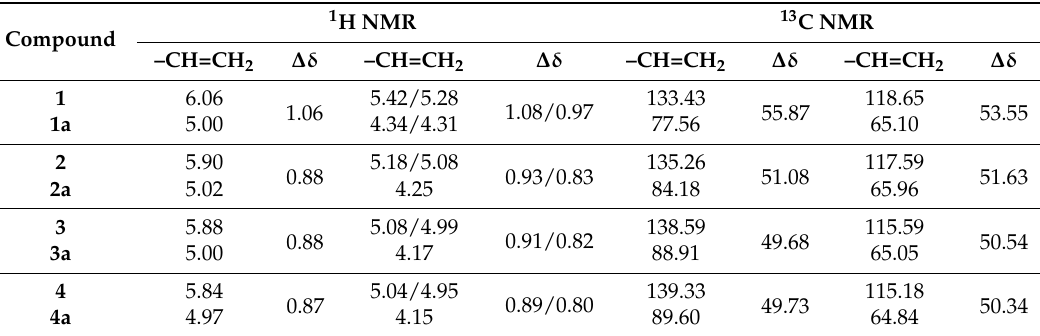
Table 2. Selected 1 H and 13 C chemical shifts of the vinyl group of the ligands 1 – 4 and the corresponding complexes 1a – 4a 1 . 1 H Compound